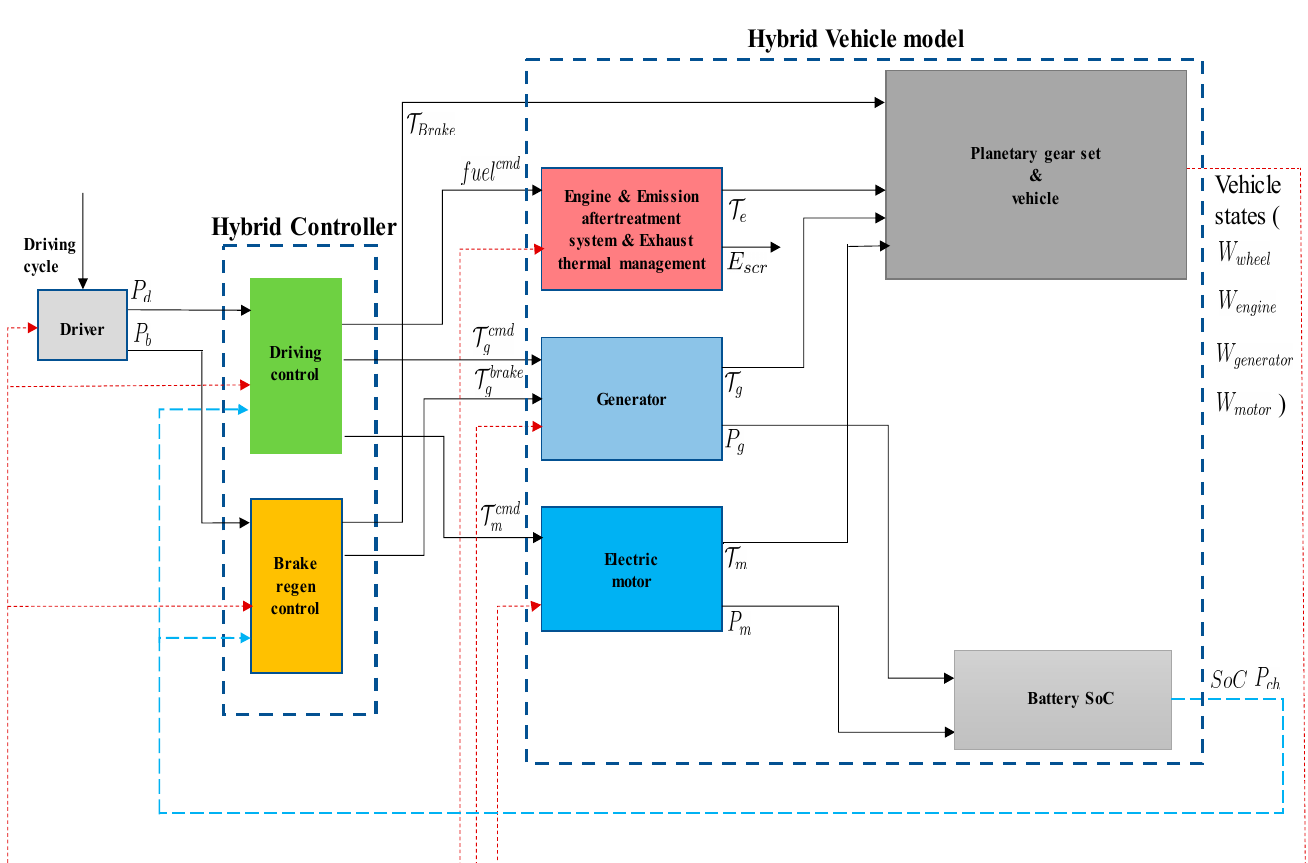
Figure 2. Schematic of the module composition and signal of the DHEV. Table 1. Constants nomenclature of the DHEV vehicle model.